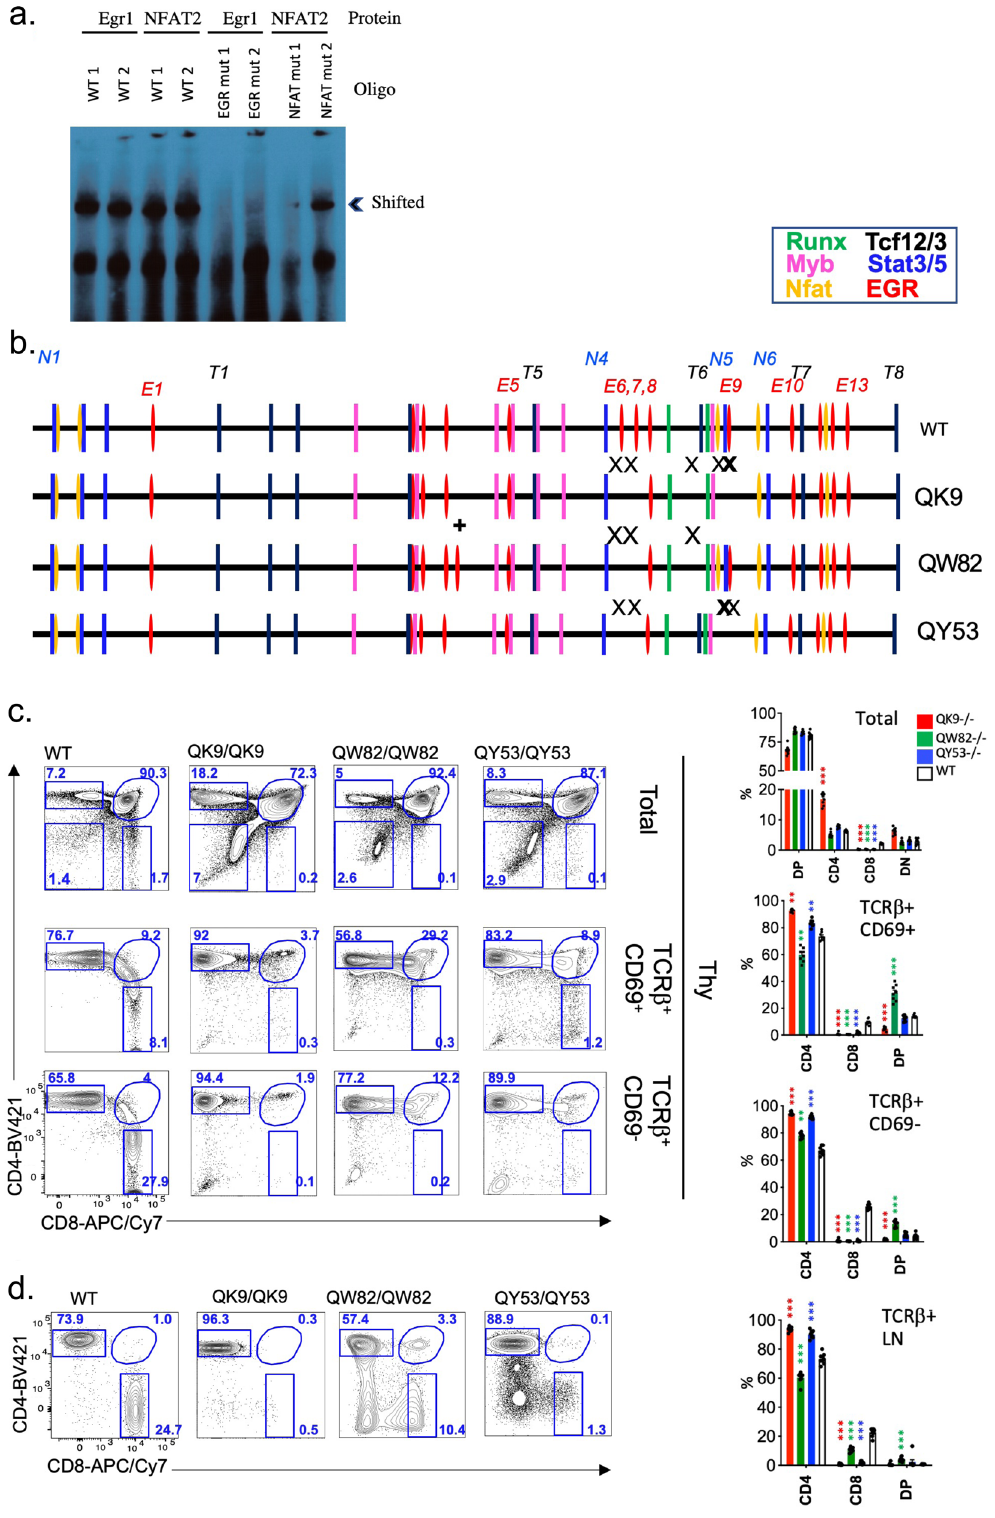
Fig. 7 Mutation of EGR and NFAT-binding motifs adjacent to conserved Runx sites impairs Sil ThPOK function. a EMSA analysis showing EGR1 and NFAT2 binding to oligos comprising wt silencer sequence (region surrounding Runx sites), or mutated at consensus EGR or NFAT motifs, as indicated. b Position of TF consensus binding sites for wt silencer, or indicated variant alleles. FACS analysis of TCR β , CD69, CD4, and CD8 expression of total thymocytes, gated thymocytes ( c ), and peripheral T-cell subsets ( d ) of wt mice or mutant lines, as indicated. Results are representative of multiple experiments. N = 6 independent animals per strain. Data are presented as mean values + / − SEM. A P value < 0.05 was considered signi fi cant. Statistical signi fi cance was determined between indicated mutant mice and ThPOK + / + mice by one-way ANOVA with post hoc Tukey HSD, and indicated by asterisks (* P < 0.01; ** P < 0.005; *** P < 0.001). Statistical signi fi cance was calculated for each indicated mutant line relative to wt mice.